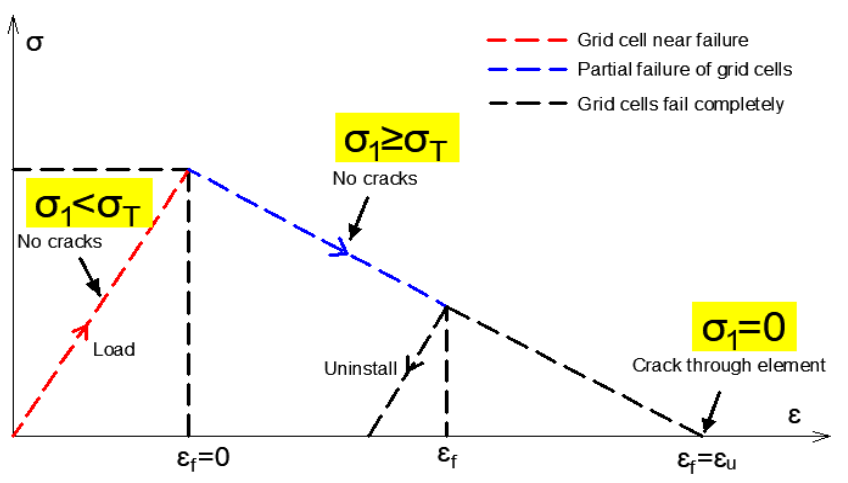
Figure 11. Diagram of softening model σ 1 − ε F